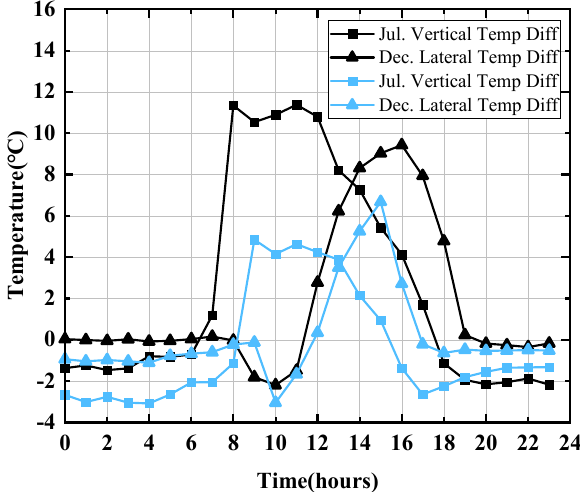
Figure 8. Measured temperature difference curve of the steel box girder. The diurnal variation of the steel box girder in summer is similar to that in winter. The temperature difference changes less before 6:00 than after. During the period from 6:00 to 18:00, the temperature difference becomes more significant due to the change in the sun’s orientation and the change in the radiation intensity, respectively. After 18:00, the temperature difference tends to be stable. During the period from 9:00 to 11:00, when the sun passes directly above the components, the reflected radiation of the bottom plate is weakened, due to the influence of the steel box girder itself. However, with the change in the angle of the solar radiation, the reflected radiation received by the bottom plate gradually increases. Therefore, the temperature difference changes from small to large.